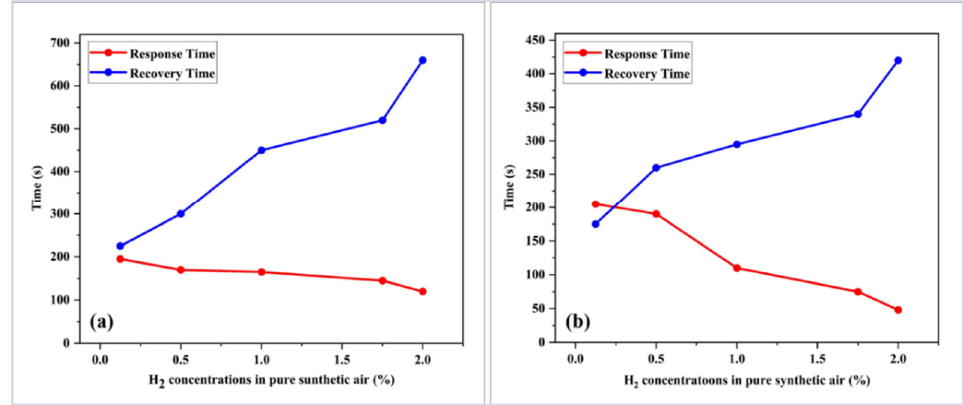
Figure 17. Effect of H 2 concentrations on the response and recovery times of ( a ) GO and ( b ) Pd/GO nanocomposite-based sensors at 100 °C.